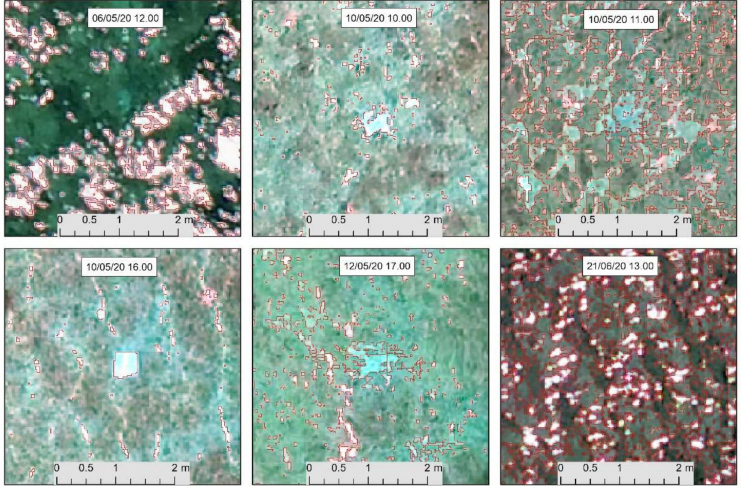
Figure 3. An underwater tile as it is detected in the different orthophoto-maps. The red features describe the isolated areas by the adaptive threshold, the white square corresponds to the actual size of the tile. The best-described tile is on 10/05/20 at 16.00 as the sea-surface is calm and the sea-bed well